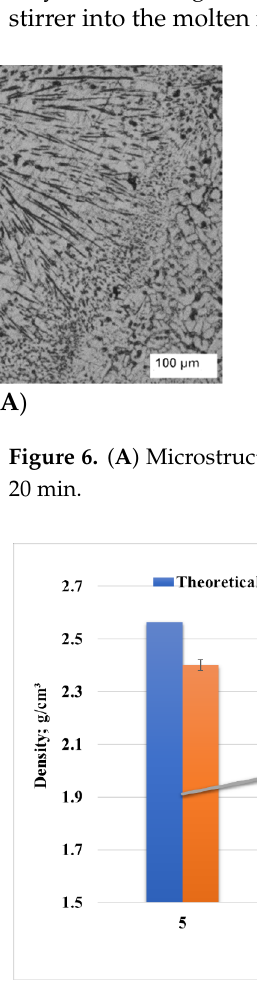
Figure 7. Theoretical and experimental densities of Al6061/TiO 2 (1 wt.%), together with their porosity volume fractions for different stir casting duration times.